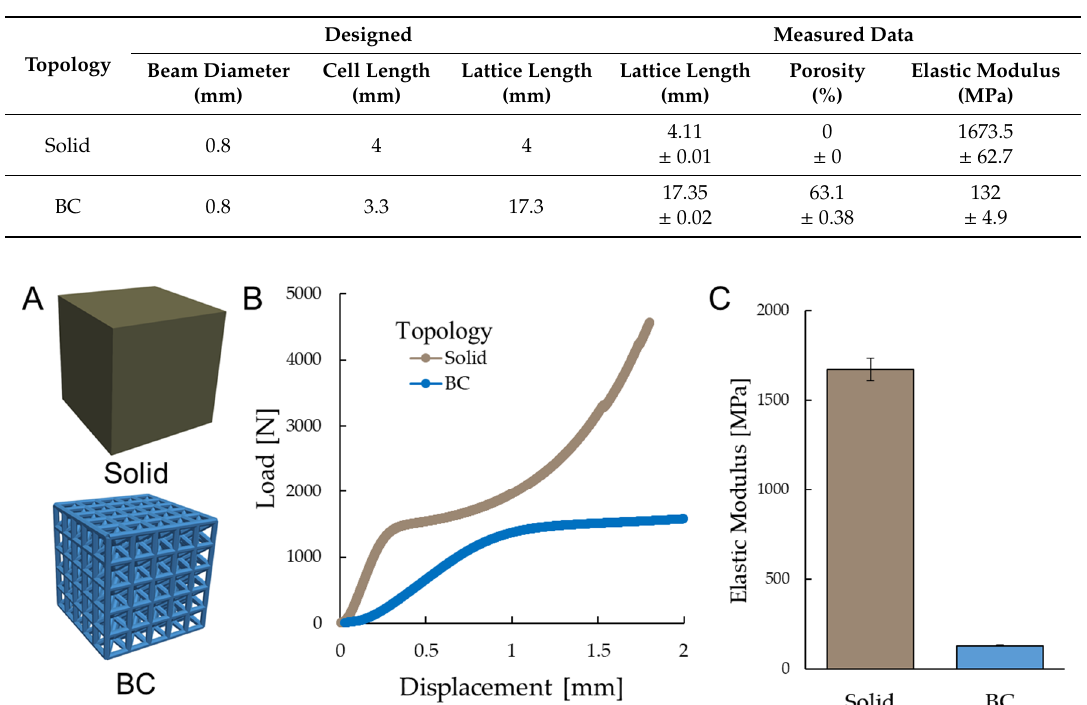
Figure 6. Material characterization for ( A ) Solid and BC lattice topologies, ( B ) their load-displacement curves, and ( C ) elastic moduli.